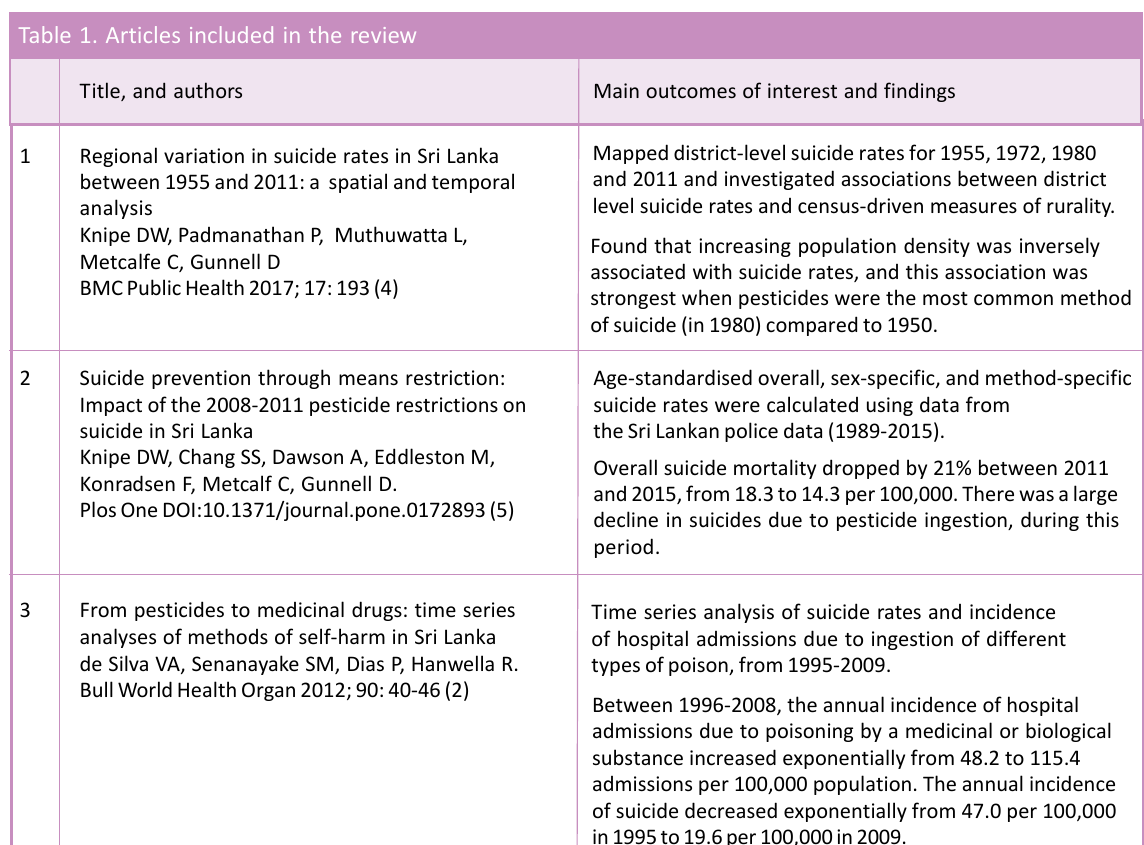
Table 1. Articles included in the review